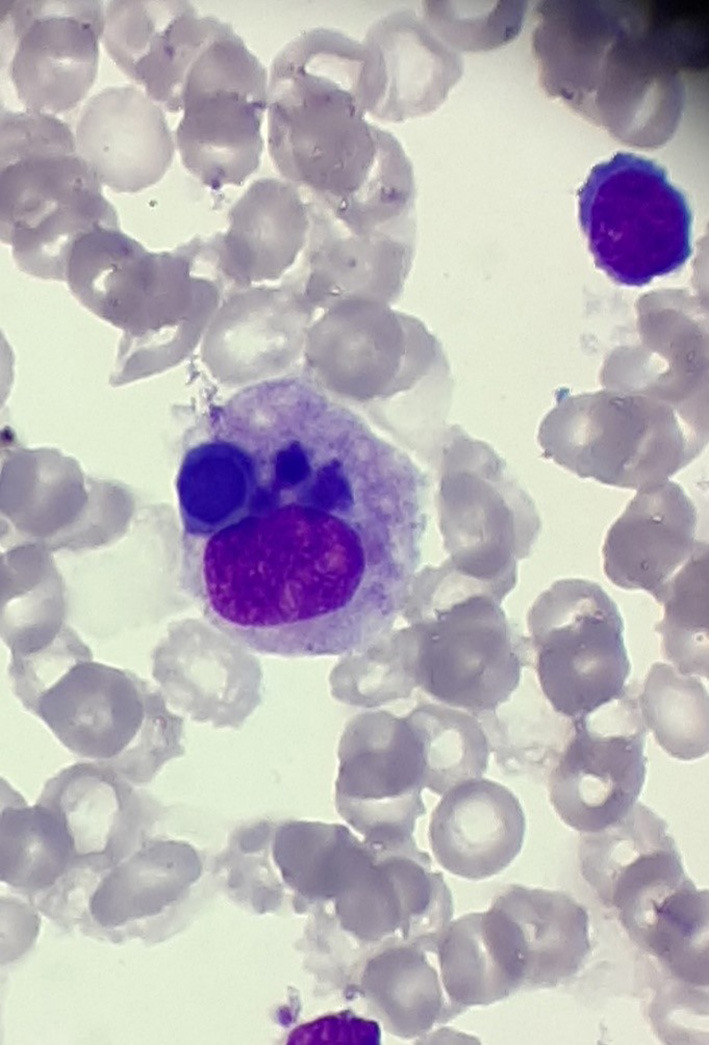
Hemophagocytosis in bone marrow; magnification, ×1,000.